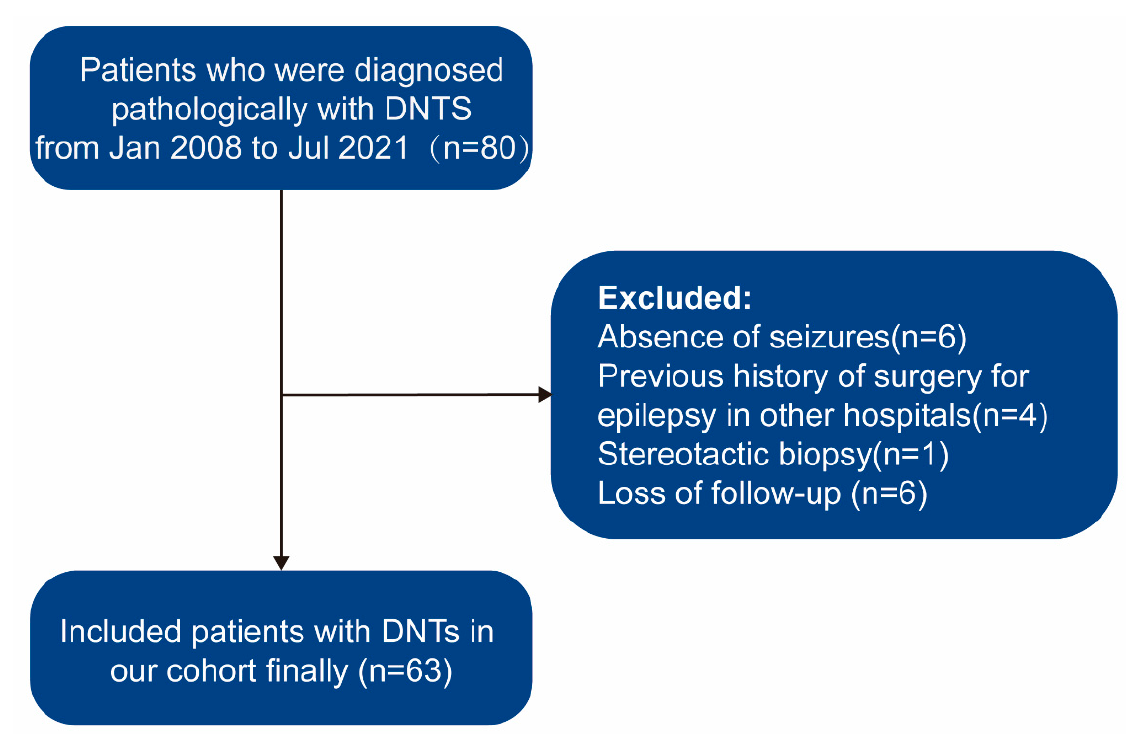
Figure 1. Flowchart describing the procedures and exclusion and inclusion criteria of this study. DNTs, dysembryoplastic neuroepithelial tumors.